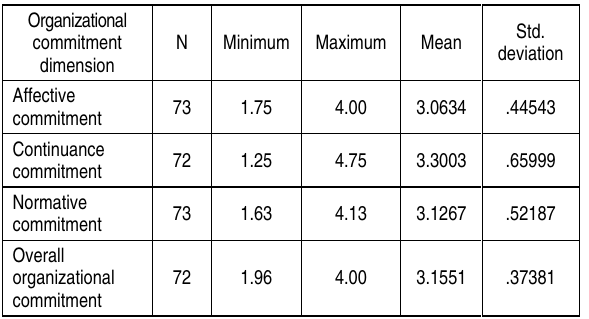
Table 2. Mean, std. deviation, minimum